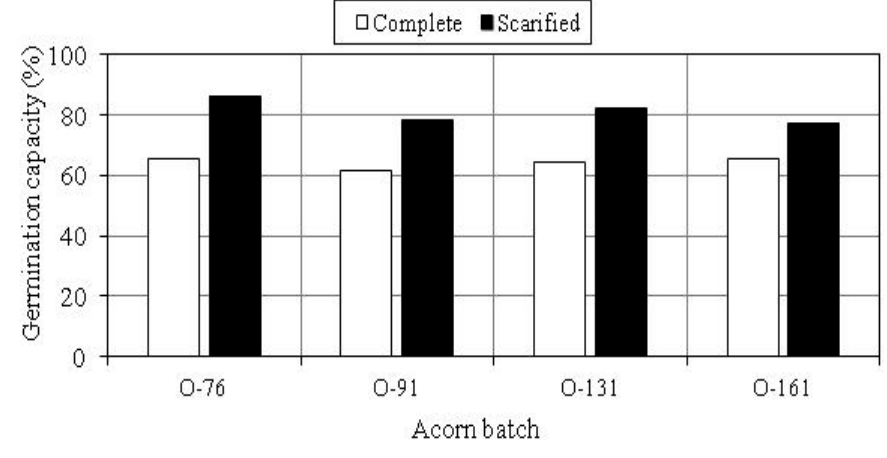
Figure 2. Germination capacity of complete and scarified pedunculate oak acorns.